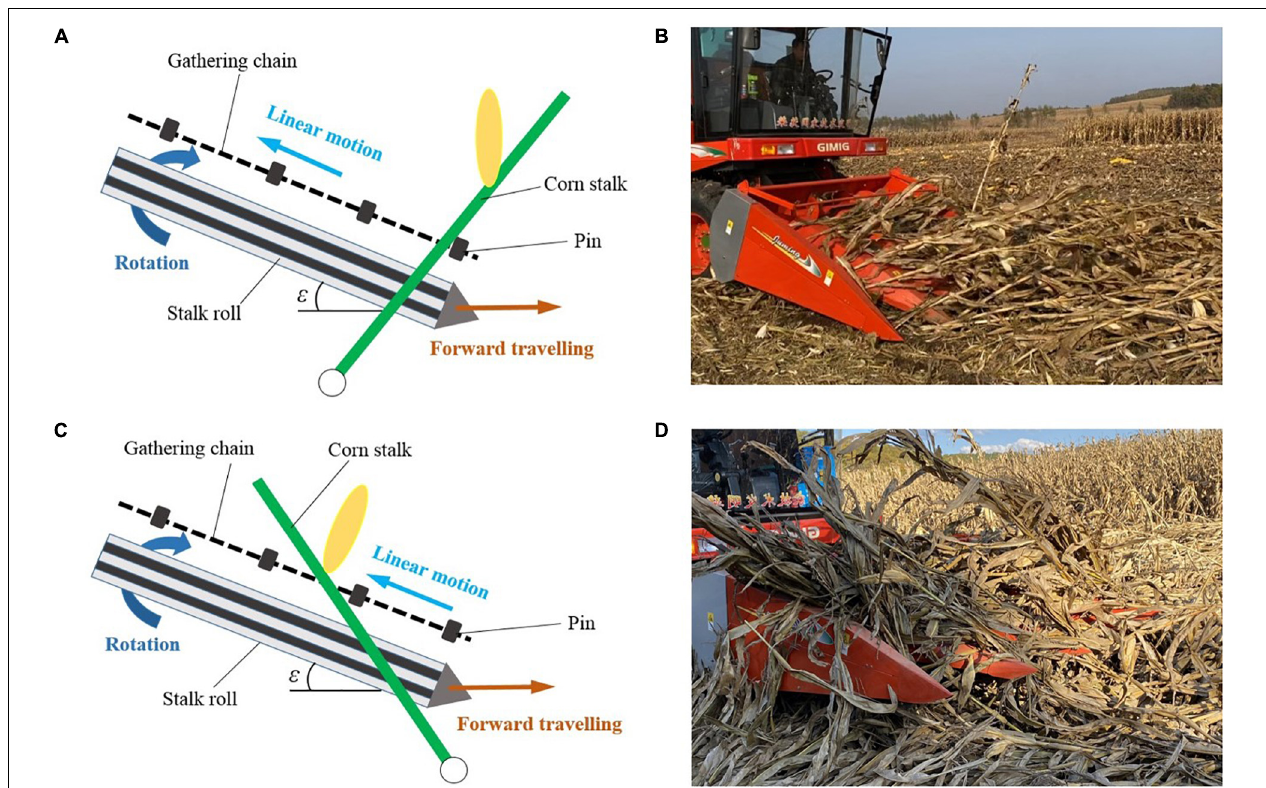
FIGURE 11 | Corn harvested in the forward and reverse directions of lodging. (A) Motion relationship between corn header and forward lodged corn stalks; (B) corn harvested smoothly in the forward direction; (C) motion relationship between corn header and reverse lodged corn stalks; (D) header blockage in the harvesting of reverse lodged corn.